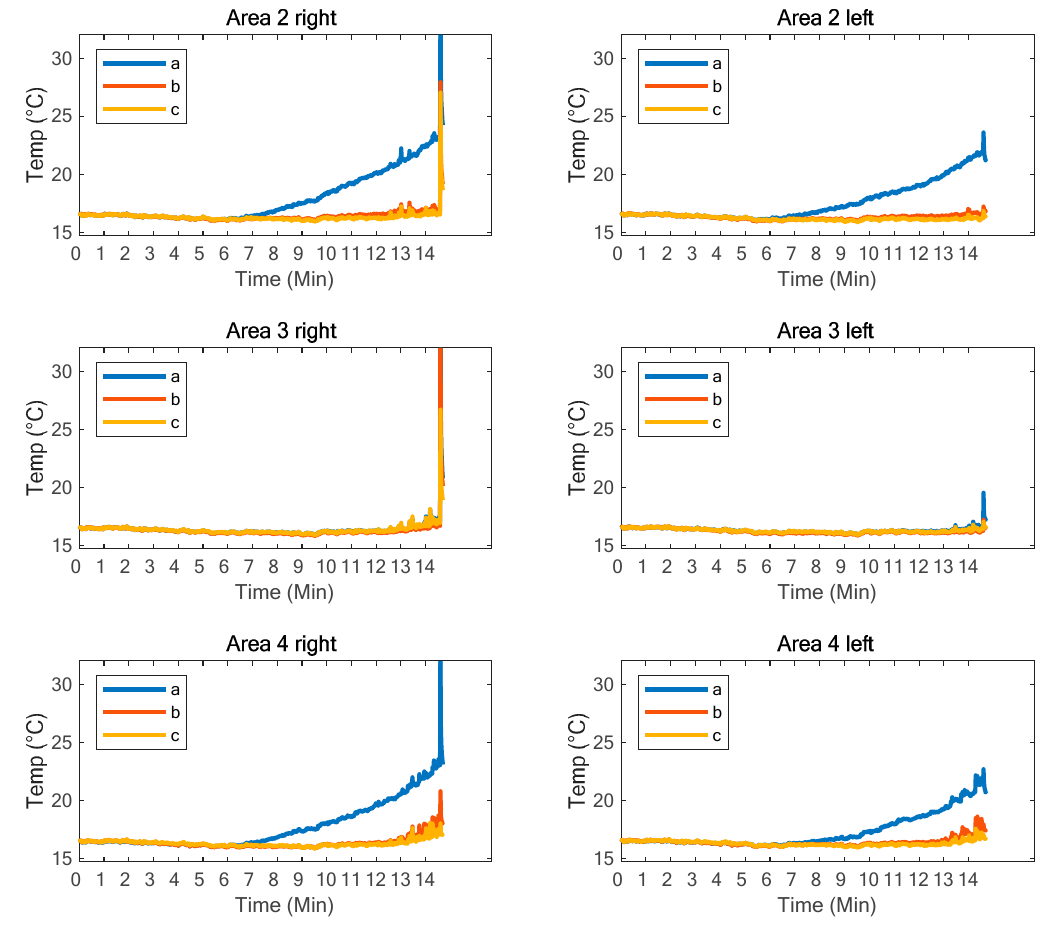
Figure A1. Average temperature of the main trunk areas during the whole test (left and right zones). Design CONV, ESDD = 0.42 mg/cm 2 , and a fog rate of 3 L/hr.